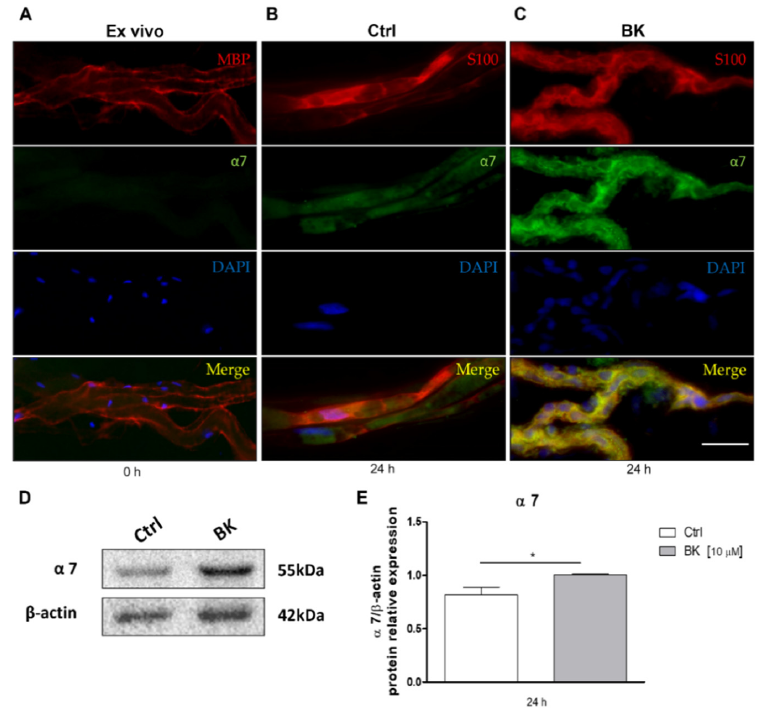
Figure 2. α 7 nAChRs expression in sciatic nerve after axotomy and in cultured Schwann cells. ( A – C ) Immunostaining for α 7 nAChRs (green) and MBP or S100 β (red) was performed on teased fibers from sciatic nerve ex-vivo ( A ) or in cultured nerve segments maintained for 24 h in the absence ( B ) or presence ( C ) of 10 µ M BK; scale bar: 50 µ m. ( D ) The α 7 nAChRs expression was also evaluated by Western blot analysis on cultured Schwann cells in the absence or presence of 10 µ M BK. ( E ) Graph shows the densitometric analysis of the bands obtained from three independent experiments, normalized against the housekeeping protein, GAPDH (n = 3; * p <